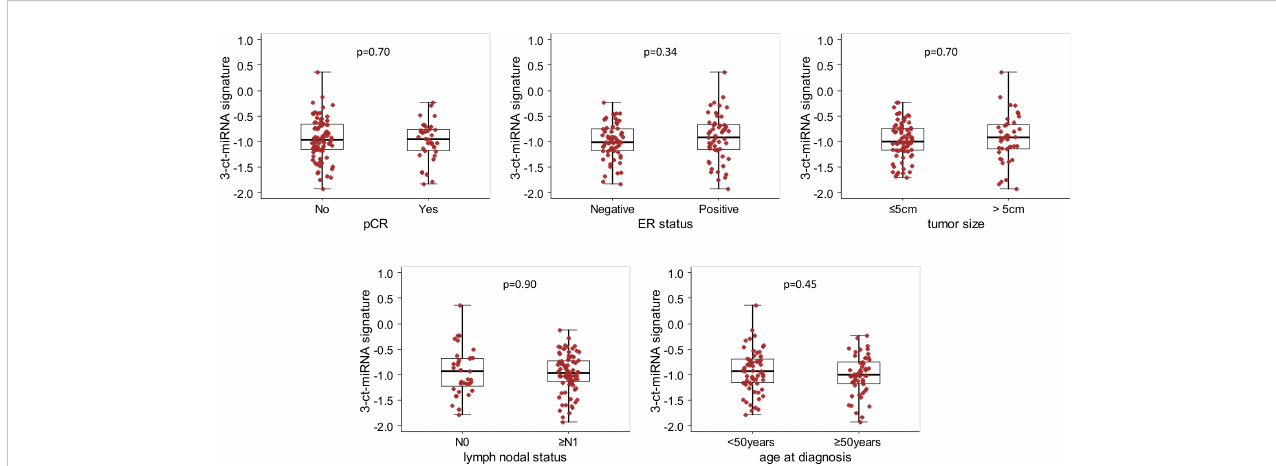
FIGURE 1 Box Plot of the 3-circulating miRNA signature according to clinical variables in the whole study cohort. Distribution of the 3-circulating miRNA signature expression levels according to pathological complete response (pCR), estrogen receptor (ER) status, primary tumor size, nodal status and age at diagnosis. Each box indicates the 25 th and 75 th percentiles. The horizontal lines inside the box indicate the median, and whiskers indicate the extreme measured values; individual value of the signatures are represented by dots. p=p.value of the Wilcoxon